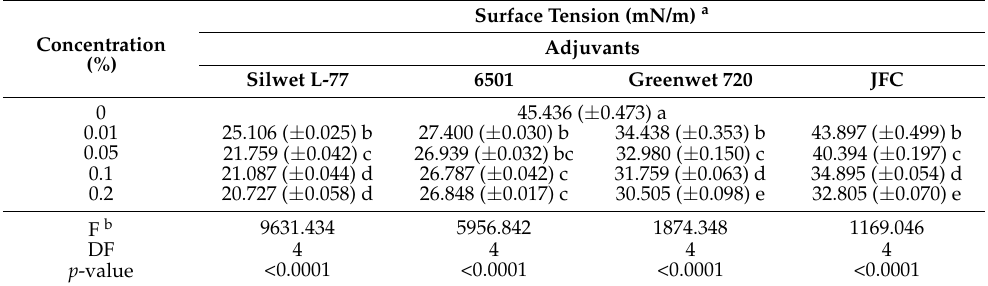
Table 2. Surface tension of bifenthrin diluent mixed with adjuvants in different concentrations. Concentration